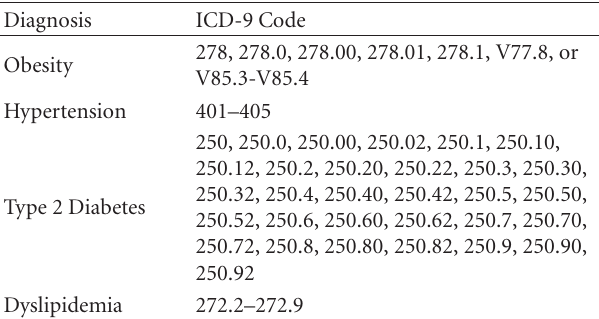
Table 3: ICD-9 Diagnostic Codes.